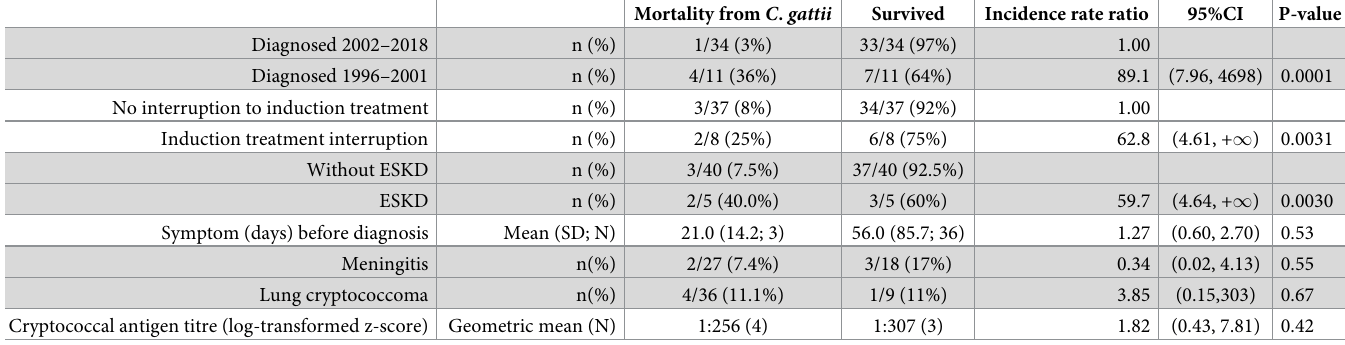
Table 5. Associations between clinical and laboratory variables and death attributed to Cryptococcus gattii disease (multivariable